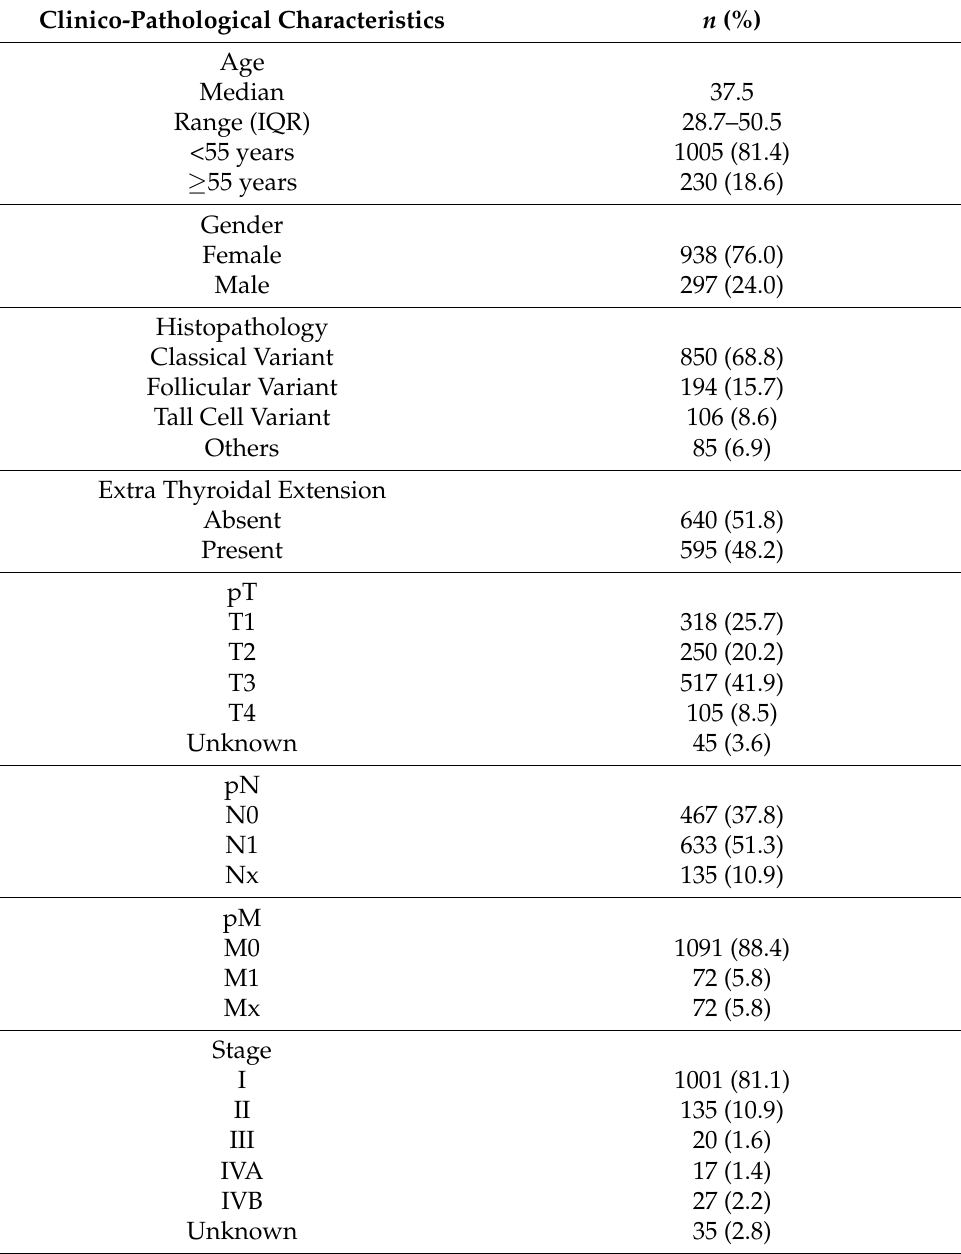
Table 1. Clinico-pathological variables of the patient cohort ( n =